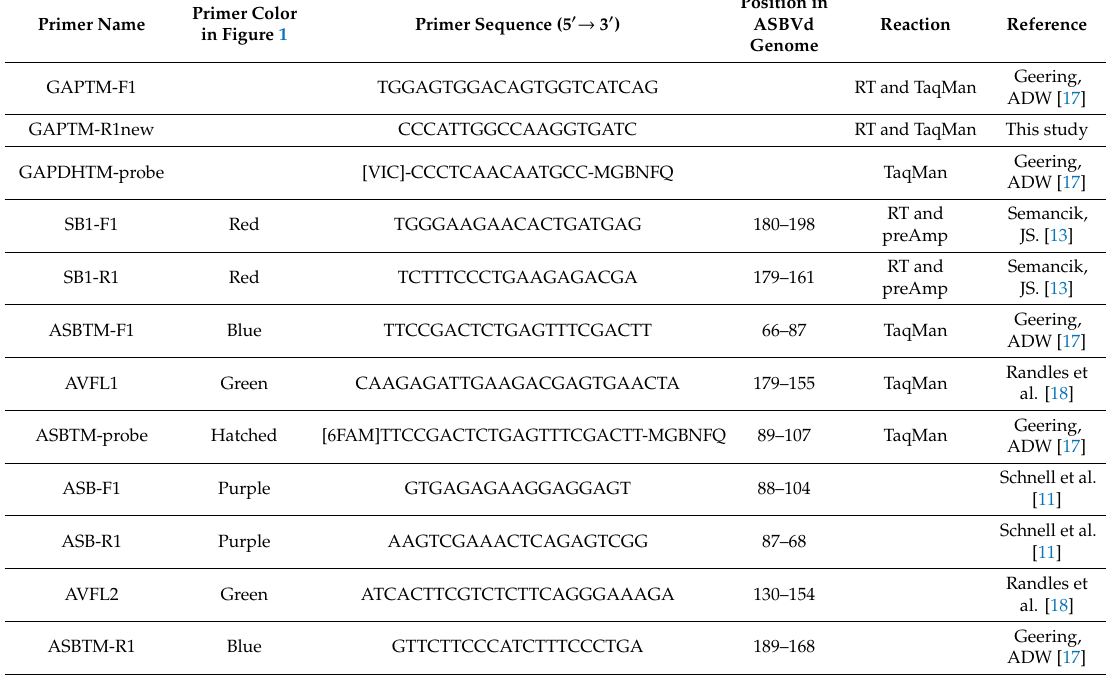
Table 2. Primers and probes for ASBVd and glyceraldehyde phosphate dehydrogenase (GAPDH) control for TaqMan and SYBR-green assays. Primer name and sequences are shown with base pair position in the ASBVd genome, detection methods used in this study, and target